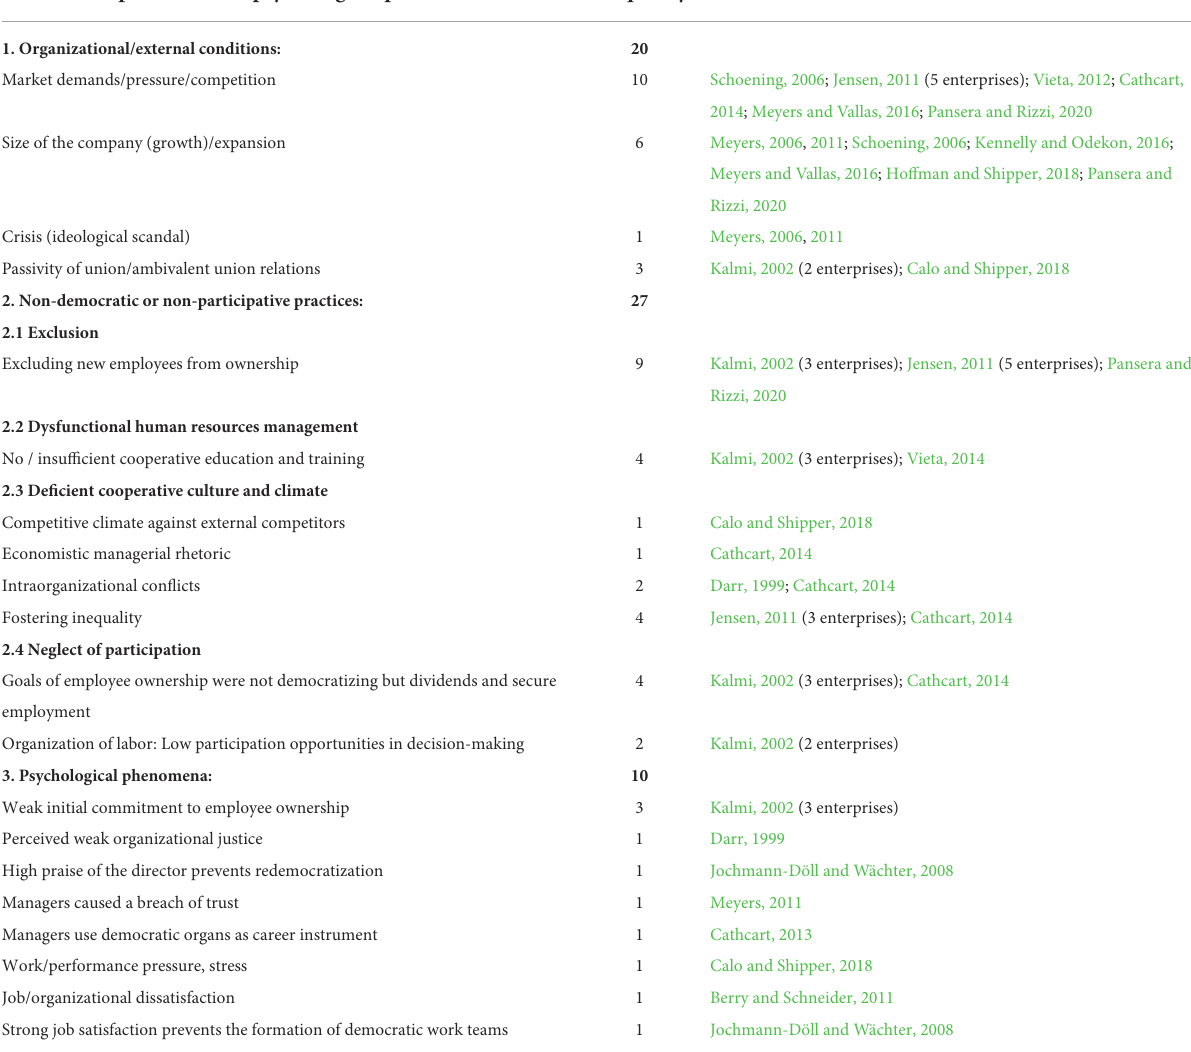
TABLE 3 Frequencies of conditions, practices, and psychological phenomena of all forms of degeneration tendency mentioned ( n = 20 enterprises). Conditions, practices, and psychological